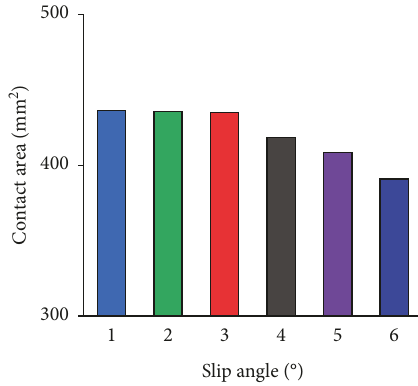
Figure 18: Contact area under different